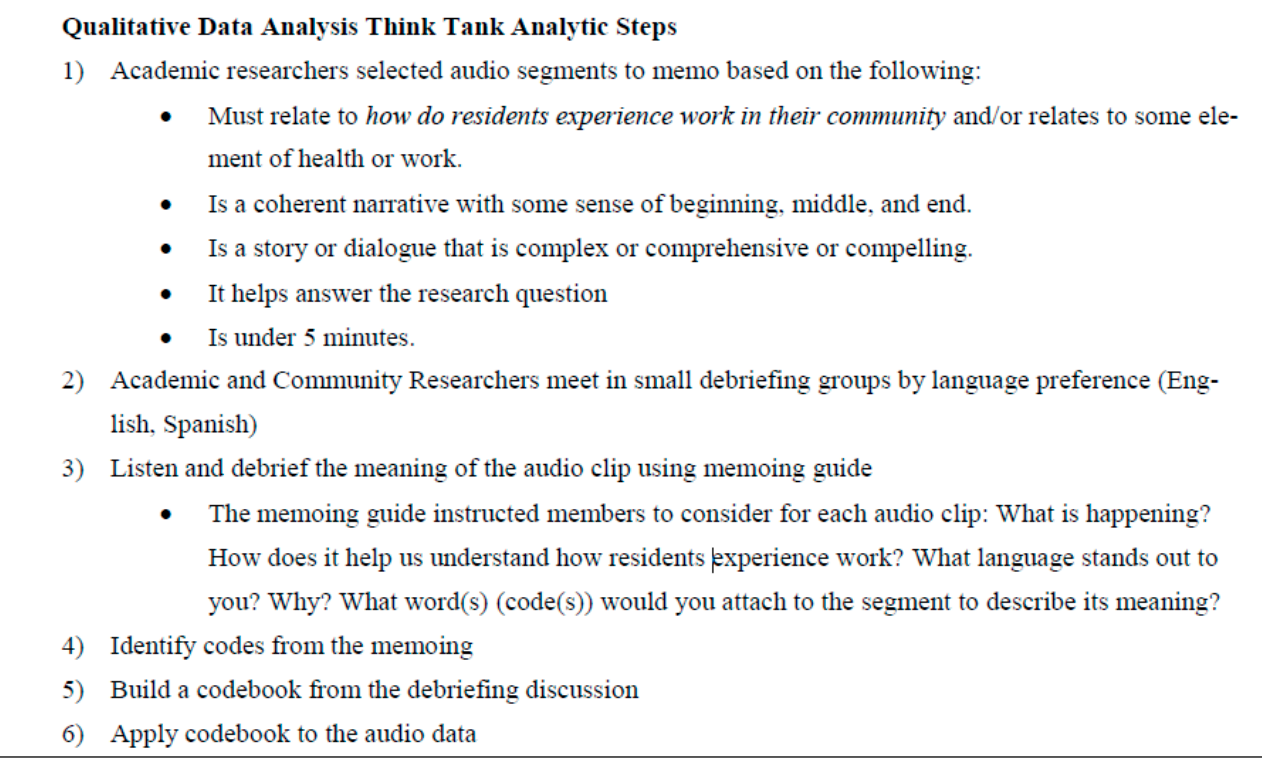
Figure 2. GLHW Qualitative Data Analysis Think Tank Analytic Steps.